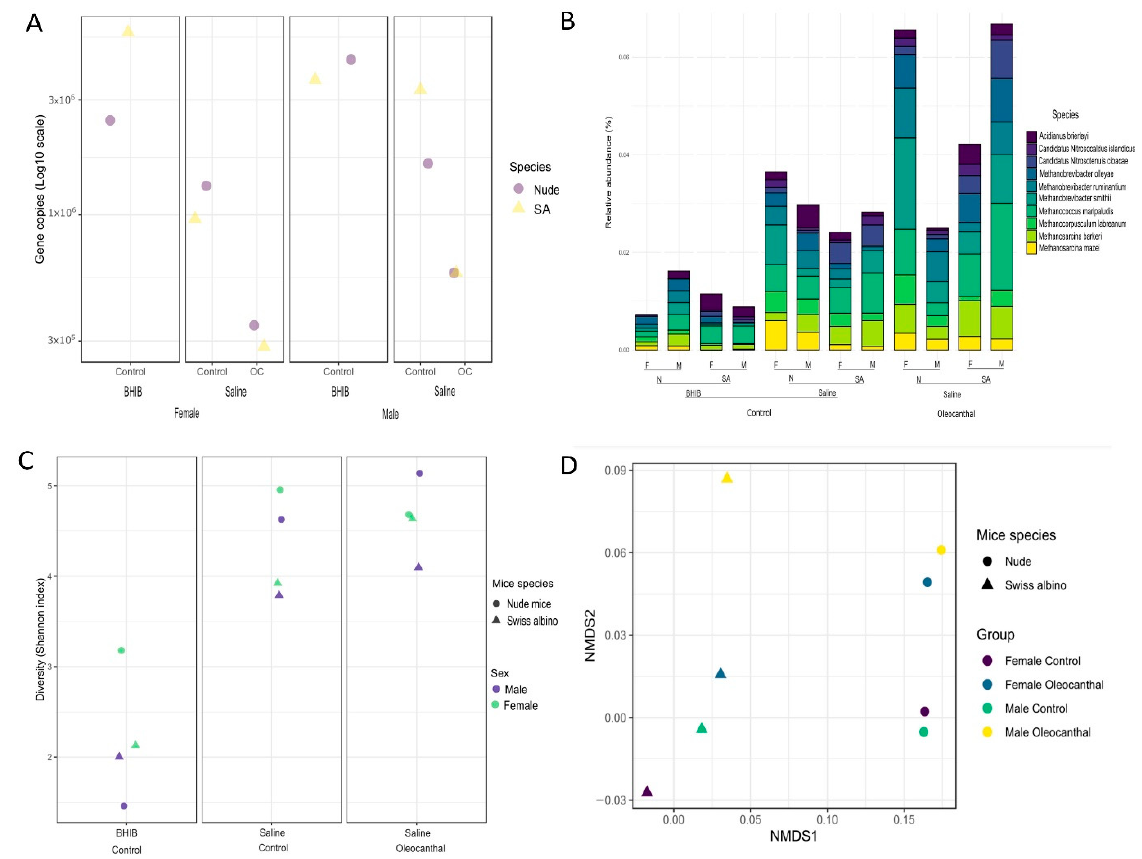
Figure 5. Comparison of metagenomic GM distribution data for OC versus both BHI and NS fermentation media controls in male (M) and female (F) nude (N) and Swiss albino (SA) mice. ( A ) Quantification of the changes in metagenomic read counts in assessing absolute abundance by qPCR determinations of the number of genome DNA equivalents per sample. ( B ) Gut bacteria global com- position changes in the ten topmost abundant bacterial species. ( C ) Comparison of the phylogenetic (alpha)-diversity variations of OC-treated versus vehicle control-treated fecal samples based on tax- onomic profiles using Shannon’s diversity index with Kruskal–Wallis chi-squared test. ( D ) Com- parison of the GM beta-diversity from taxonomic profiles at the species-level using Bray–Curtis dis- similarities and samples visualized using non-metric multidimensional scaling (NMDS).